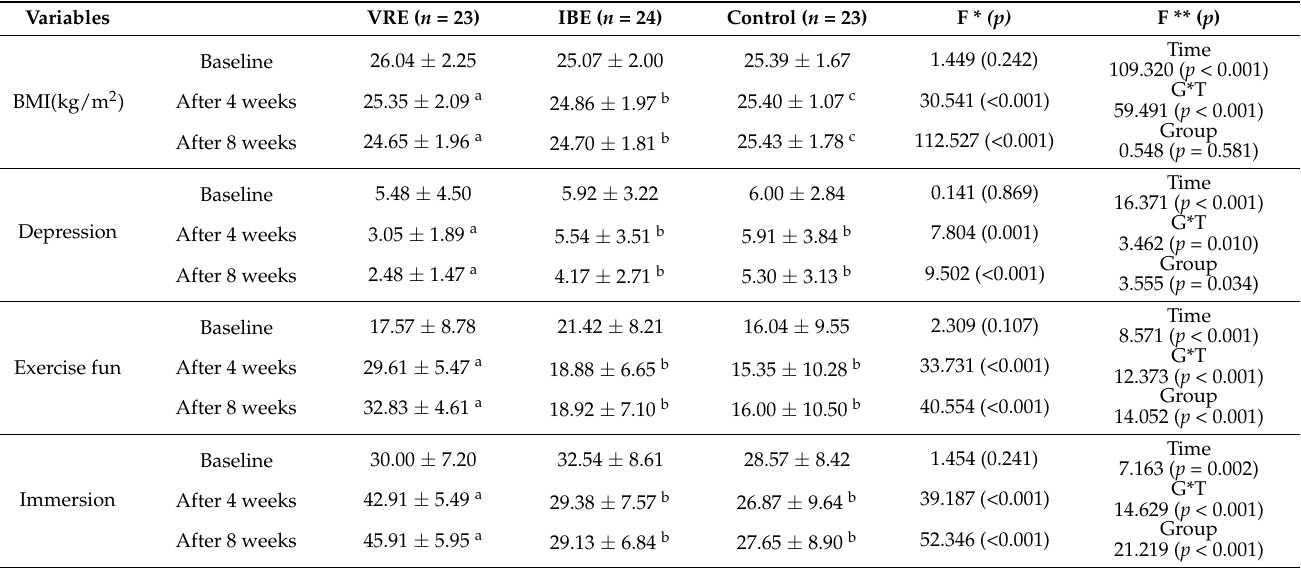
Table 2. Comparison of BMI, depression, exercise fun, and immersion among groups ( n =